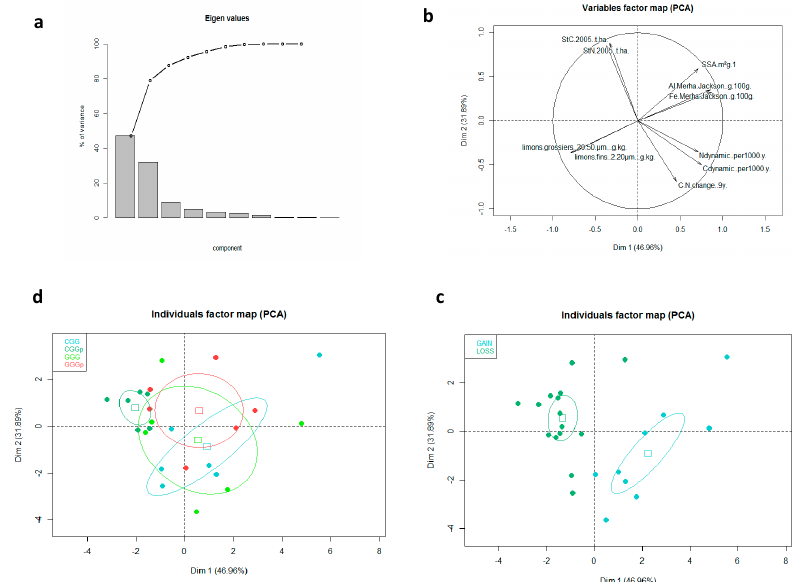
Figure 4. Principal component analysis for pedological soil parameters. a Eigenvalues of principal components; b Variable factor map; c Individual factor map belong to treatment; and d Individual factor map belong to gain and loss C dynamic.